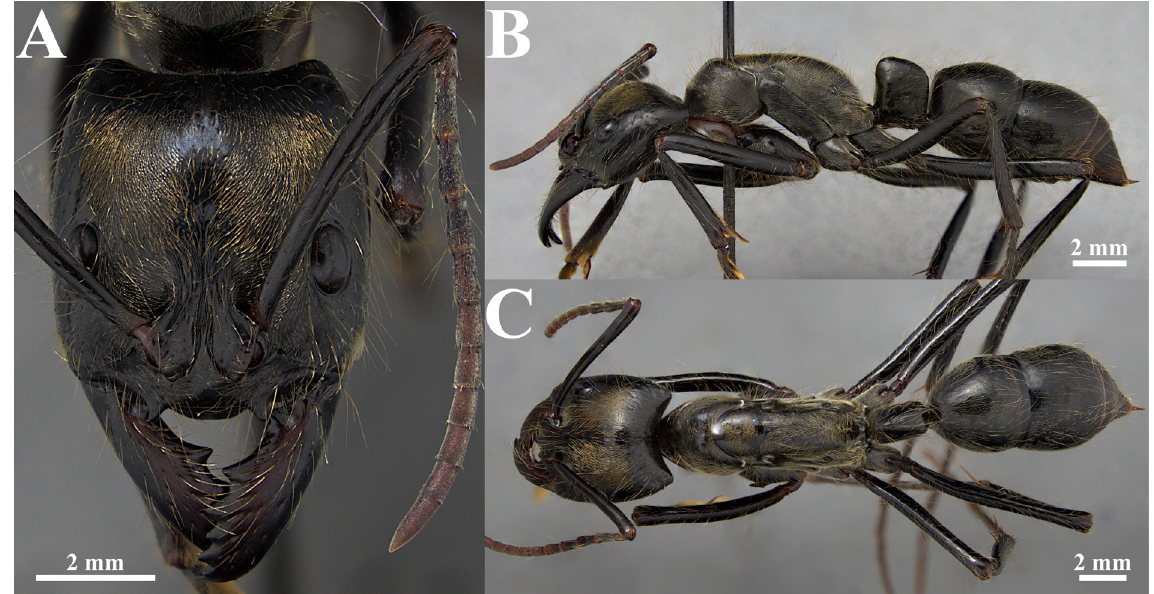
(specimen from Uchiza, Peru; DZUP 549808). A . Full- ☿